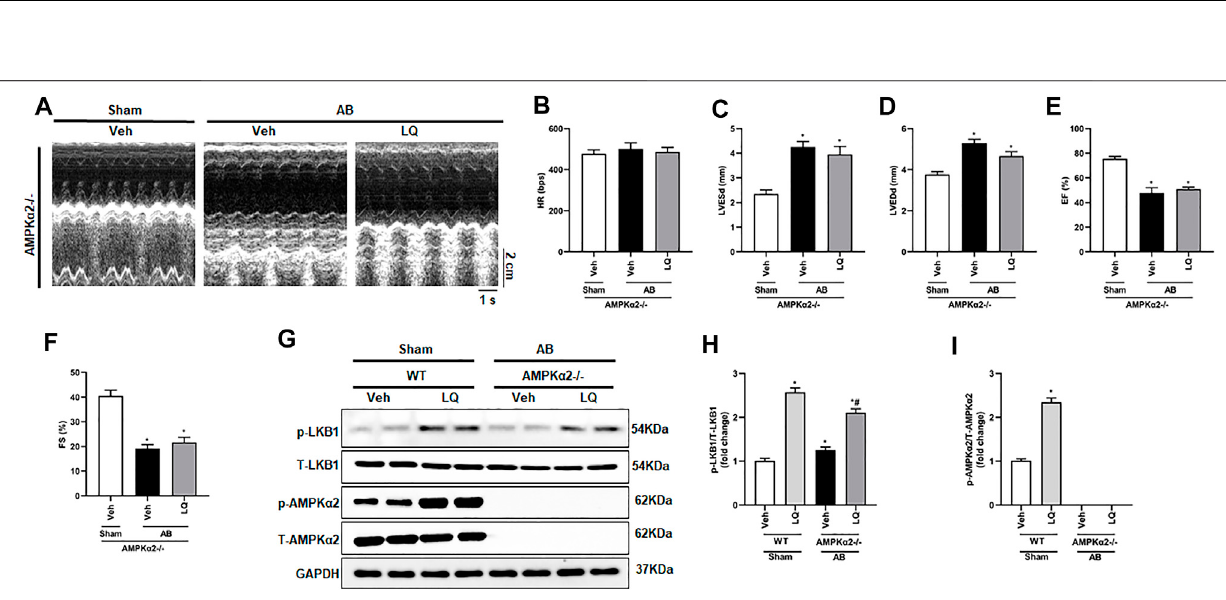
AMPK α 2 − / − mice ( Supplementary Figures S2I – L ). These data